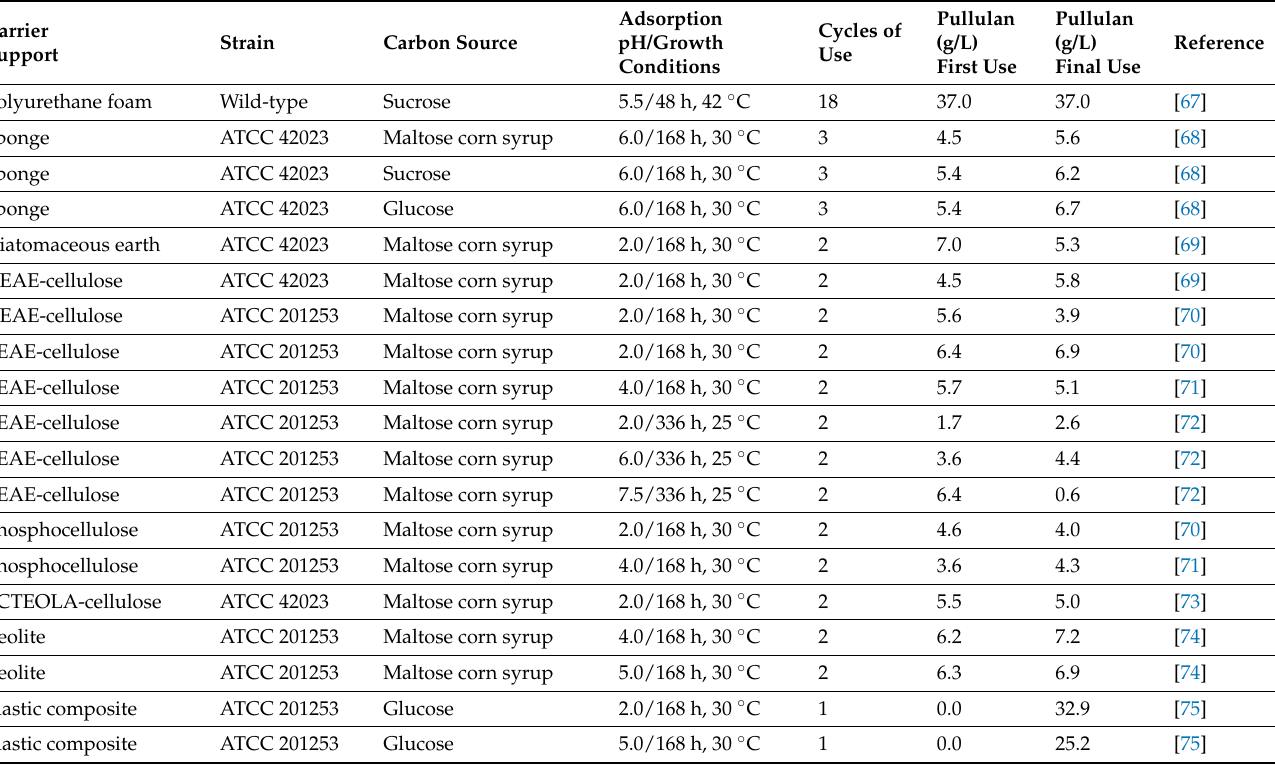
Table 1. Growth conditions and maximum pullulan production by Aureobasidium pullulans strains immobilized by carrier